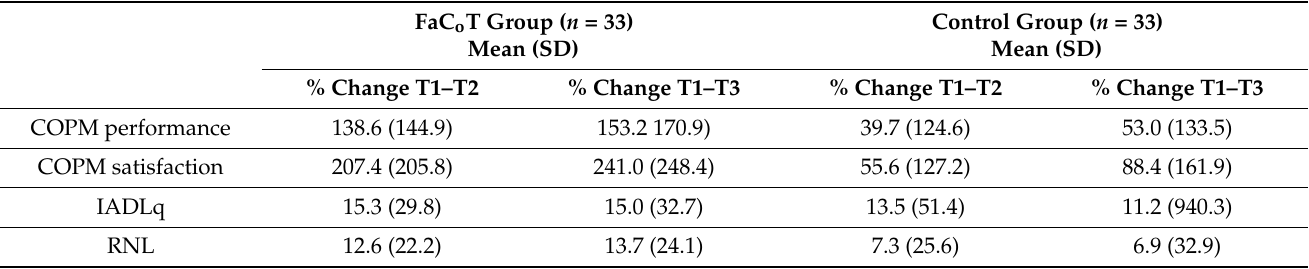
Control Group ( n = 33) Mean (SD)